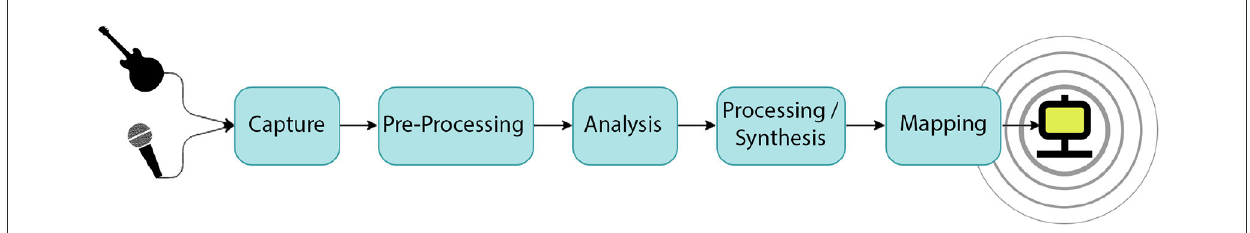
FIGURE1 Archetype of a vibrotactile augmentation system.